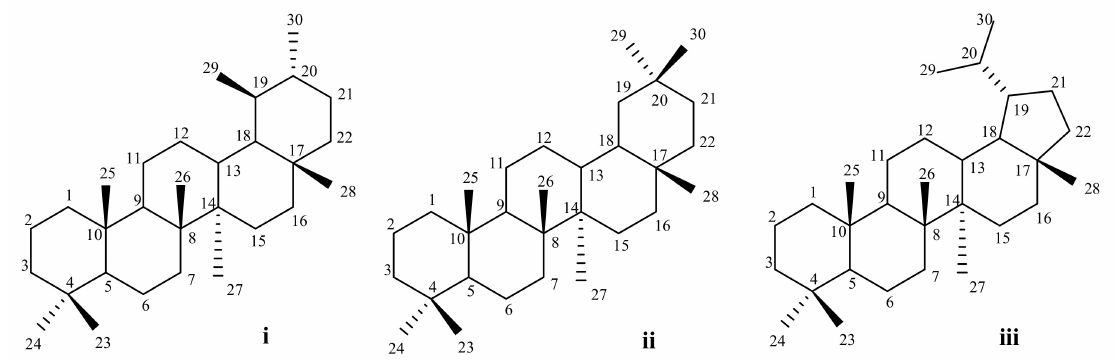
Figure 1. Three different types of triterpenoid skeletons described in this review with carbon numbering: ursane ( i ), oleanane ( ii ), and lupane ( iii